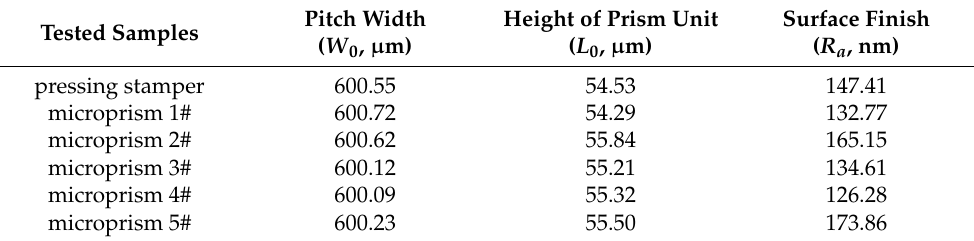
Figure 8. Measured results for the structure of a fabricated PMMA microprism by SEM ( a ) and by stylus profiler ( b ). Table 2. Measured pitch width ( W 0 ), height of prism unit ( L 0 ), and surface finish ( R a